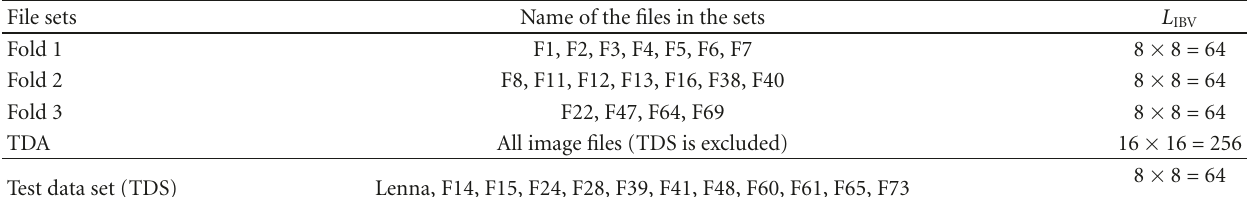
Table 1: Training and test data file sets.